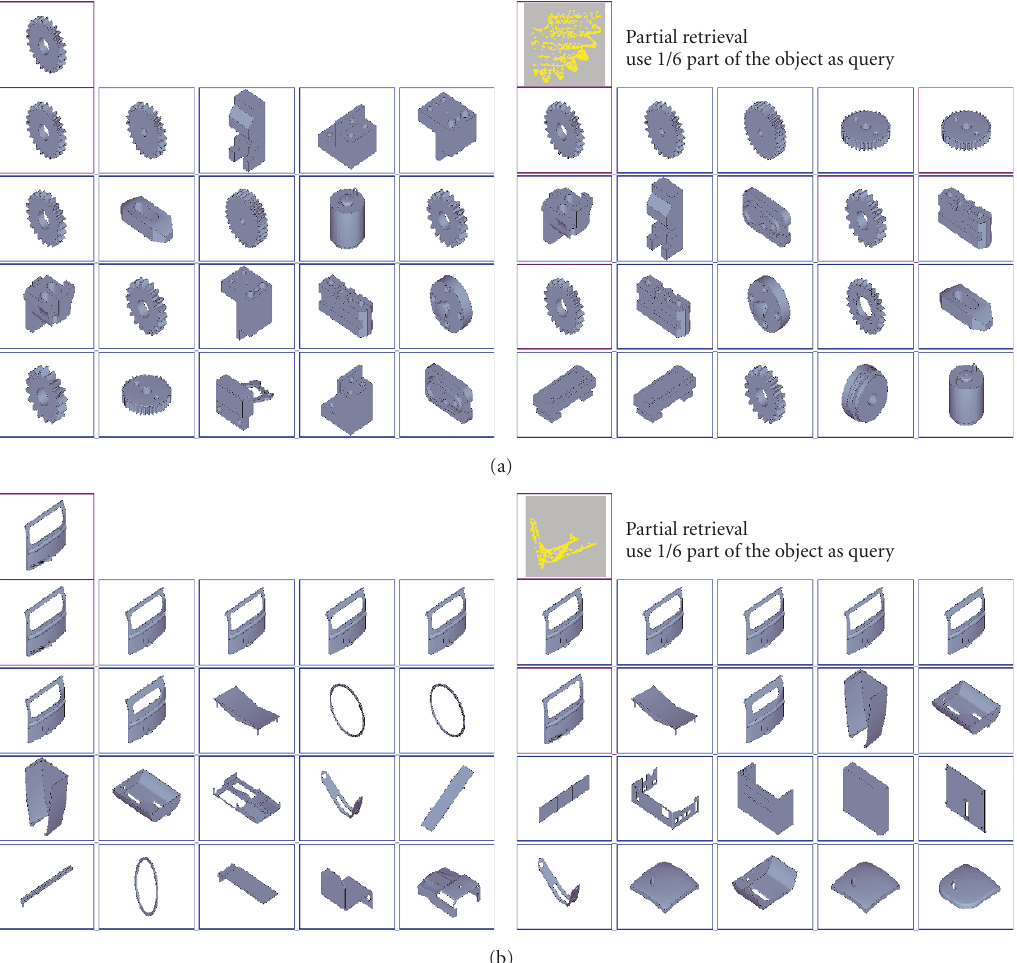
Figure 6: The example to show the di ff erence between GGR and PGR. (a) First example to show the di ff erence between Global-to-Global retrieval (GGR) and Partial-to-Global retrieval (PGR). The left group shows the GGR result using a complete model (the top-left image) as the query. The right group shows the PGR result using 1/6 part of the complete model (the small image shown in the bottom-left corner of the first image) as the query. The top 20 models are listed orderly according to the dissimilarity measurement. (b) The second example to show the di ff erence between GGR and PGR. The layout of the images is the same as that of